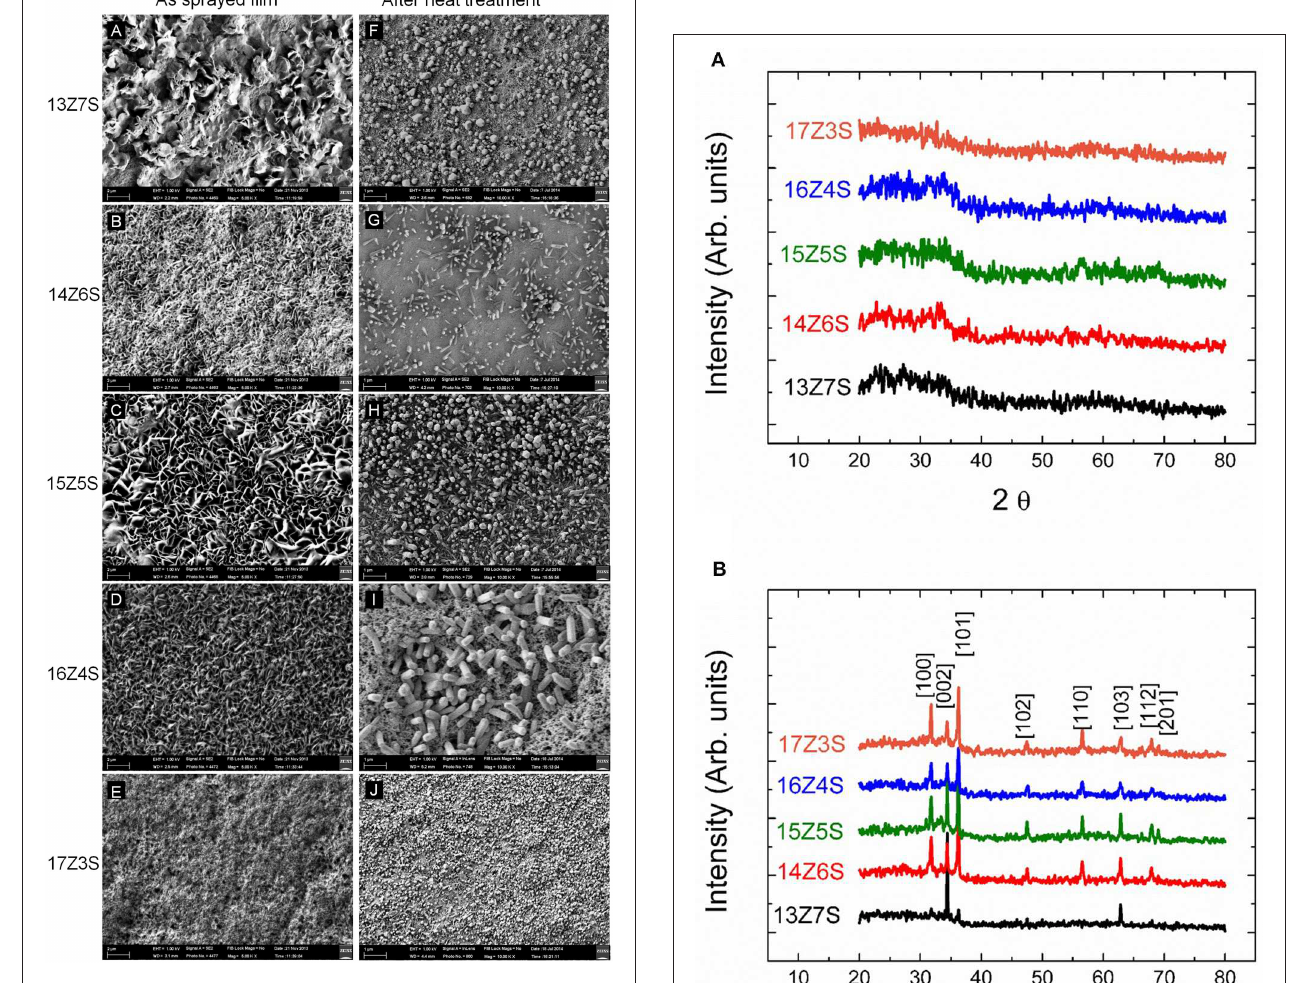
FIGURE 1 | FESEM images of nanostructures fabricated with different molar ratio of Zn and Sn in mixed precursor solution before thermal annealing (A) 13Z7S, (B) 14Z6S, (C) 15Z5S, (D) 16Z4S, and (E) 17Z3S, and after thermal annealing at 350 ◦ C for 1h (F) 13Z7S, (G) 14Z6S, (H) 15Z5S, (I) 16Z4S, and (J) 17Z3S.